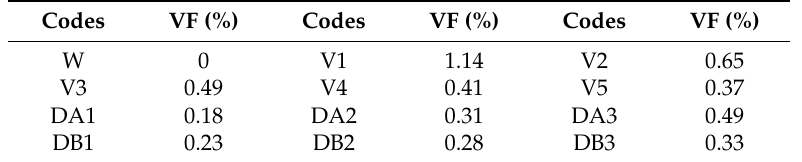
Figure 2. The schematics and codes of composites specimens. Table 2. The shape memory alloy (SMA) volume fractions (VF) of the 12 groups composite